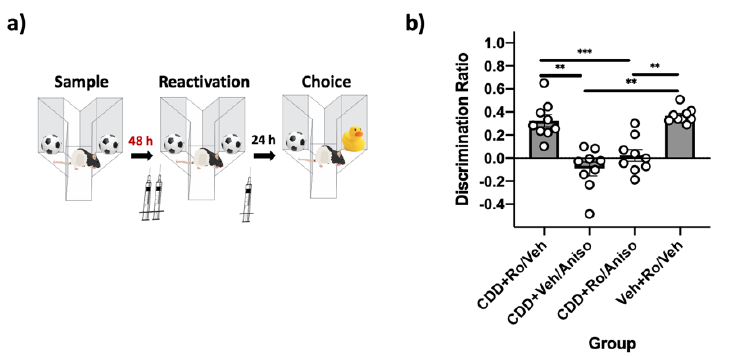
Figure 6. Destabilization of remote memories promoted by M 1 -receptor activation in PRh does not require GluN2B-containing NMDARs. ( a ) Remote SOR parameters were used, but the contextual novelty was withheld during reactivation and instead destabilization was induced by activating M 1 -receptors in PRh prior to reactivation. ( b ) Choice-phase DRs. Groups that received anisomycin following reactivation had significantly impaired memory performance compared to post-reactivation veh conditions, suggesting that CDD infusion prior to reactivation was sufficient to induce destabilization and that co-infusion of Ro-25 did not prevent M 1 -induced destabilization. Bars are mean DR ± SEM; ** p < 0.01, *** p < 0.001.